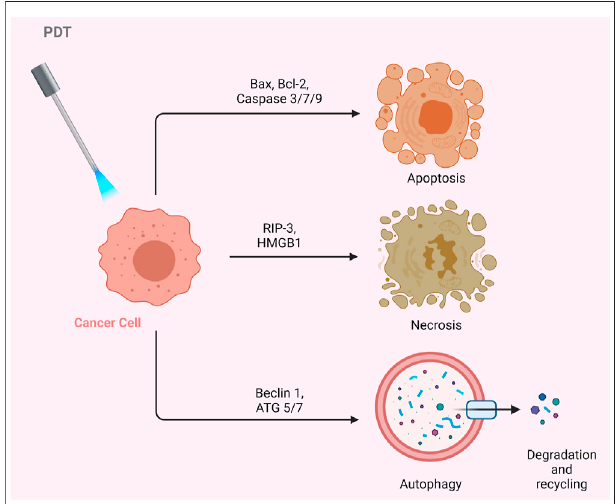
FIGURE3| EffectsofPDTonCancerCells.PDTmayresultinapoptosis, necrosis, or